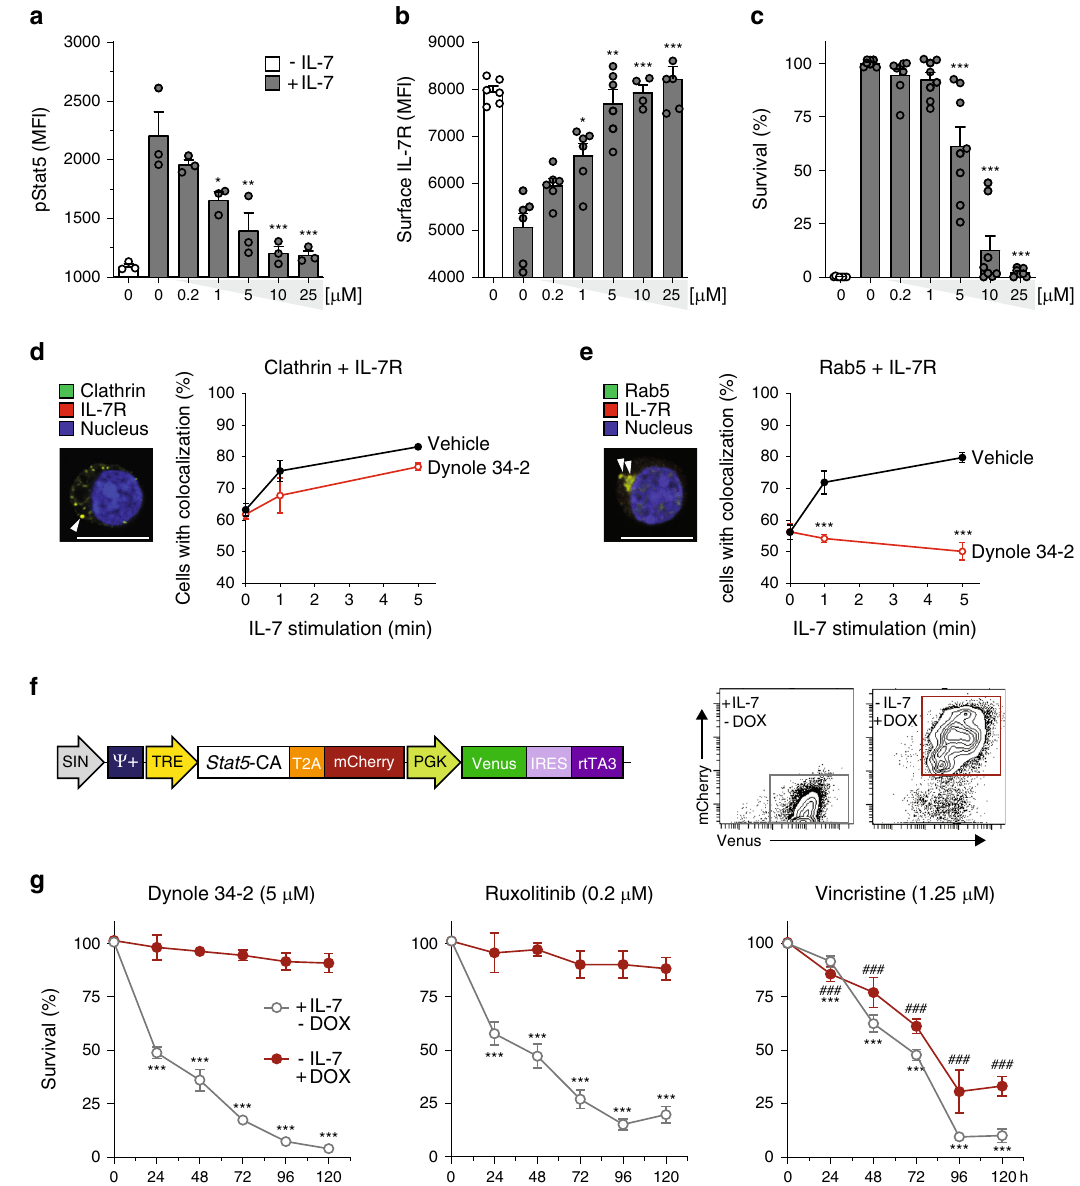
Fig. 1 Dynole 34-2 induces apoptosis by blocking Dynamin-dependent endocytosis in IL-7-dependent Ba/F3 cells. a – c Levels of phospho-Stat5 (pStat5; a ), surface IL-7R ( b ) and survival ( c ) of Ba/F3-IL7R cells with increasing doses of Dynole 34-2, assessed by fl ow cytometry. Mean± SD from three independent experiments are shown (* P < 0.05, ** P < 0.01, *** P < 0.001 compared to vehicle + IL-7). Viability normalized to vehicle + IL-7 control (grey). Baseline is untreated cells without IL-7 (white bar). d , e Representative immuno fl uorescence staining for IL-7R colocalization with clathrin ( d ) and the early-endosome marker Rab5 ( e ) in Ba/F3-IL7R cells stimulated with IL-7. Nuclei were stained using DAPI and colocalization clusters were indicated with a white arrow. Proportion of cells presenting colocalization of IL-7R with either clathrin ( d ) or Rab5 ( e ), at different time points following IL-7 stimulation, were determined by reporting the number of cells displaying at least one colocalized staining for green and red fl uorescence to the total number of cells,